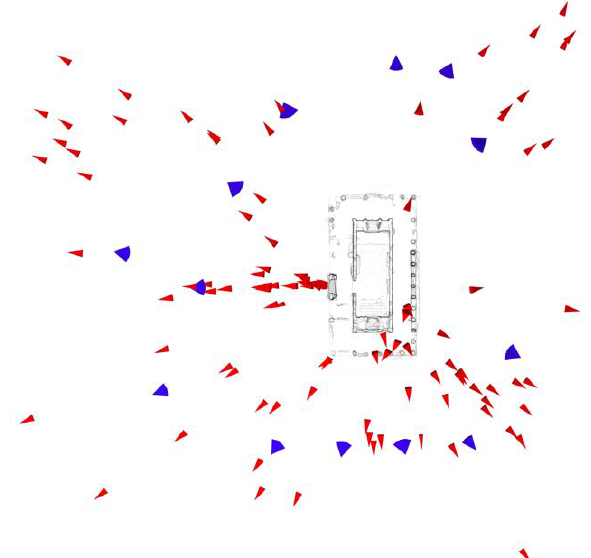
Figure 2: Exterior photo network with camera stations and viewing directions (tourist photos in red; panoramas in blue)